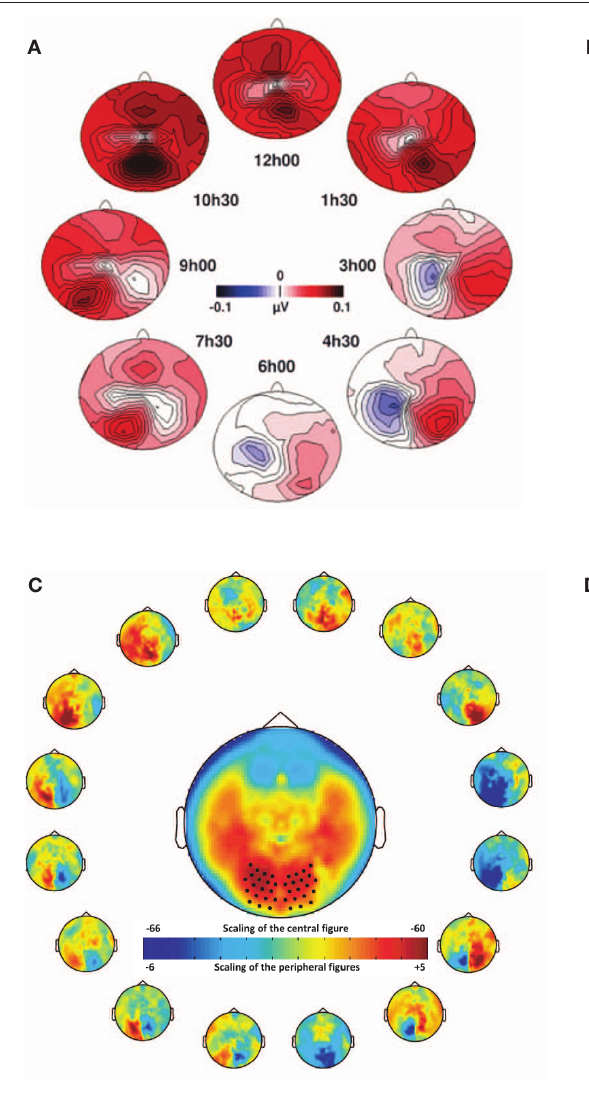
Figure 4 | The topography of the alpha activity is modulated by covert attention in different directions. This opens the possibility of making a BCI system which tracks attention in two dimensions. (A) Subjects were asked to covertly attend to one of eight directions for a 1300-ms period while fixating centrally. During this interval the alpha power was estimated using data from a 128 channel EEG system. The resulting topographies for the eight direction are shown. Both vertical and horizontal directions of covert attention clearly modulated the distribution in the alpha band. Reproduced with permission from Rihs et al. (2007). (B) In an MEG experiment subjects were asked to continuously